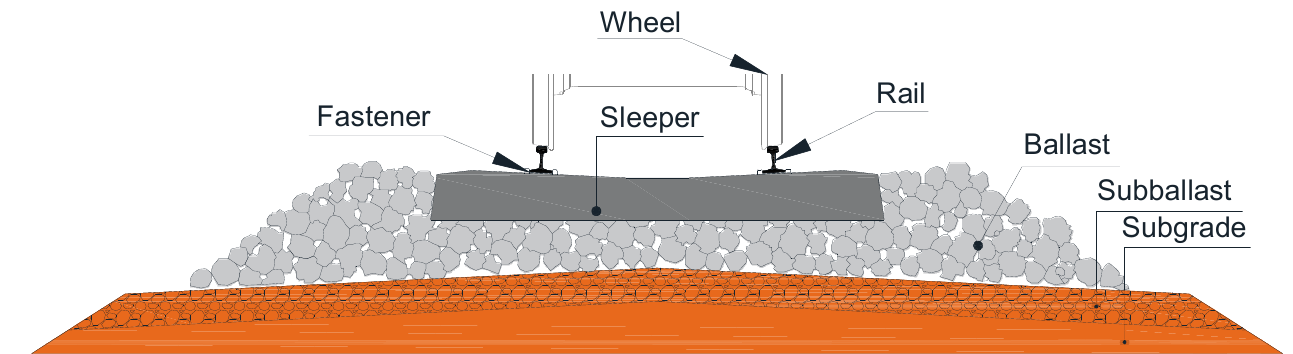
Figure 1. Components of typical ballasted railway track.